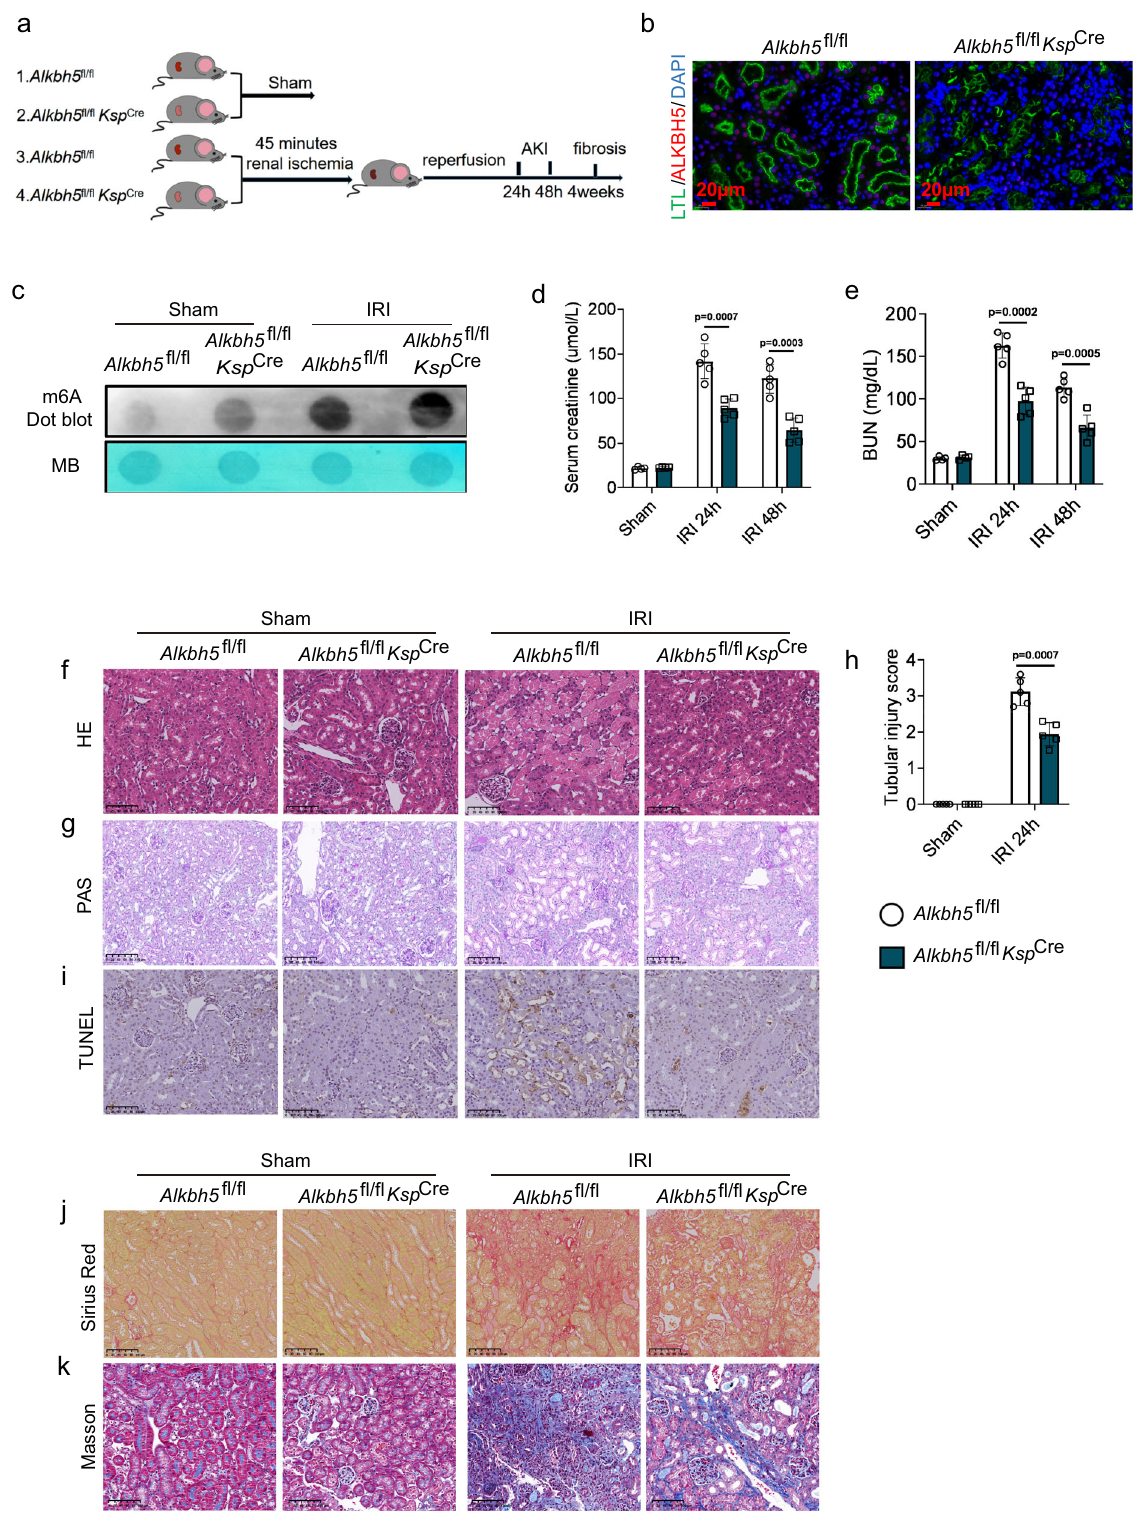
Fig. 3 | Alkbh5 de fi ciency in RTECs protected I/R-induced AKI and fi brosis. a Schematic illustrating experiment groups and treatment in 4 groups. b RepresentativeIFstainingofALKBH5(red),LTL(green),andDAPI(blue)inkidney biopsies from Alkbh5 fl / fl and Alkbh5 fl / fl Ksp Cre mice. (Magni fi cation: ×400, Scale bar: 20 μ m) ( n =5 for all groups). c m6A dot blot assessed m6A mRNA methylation of Alkbh5 fl / fl and Alkbh5 fl / fl Ksp Cre mice in IRI model. d , e Serum creatinine and BUN concentrations. f – h RepresentativeH&Eand PASstaining image and tubular injury